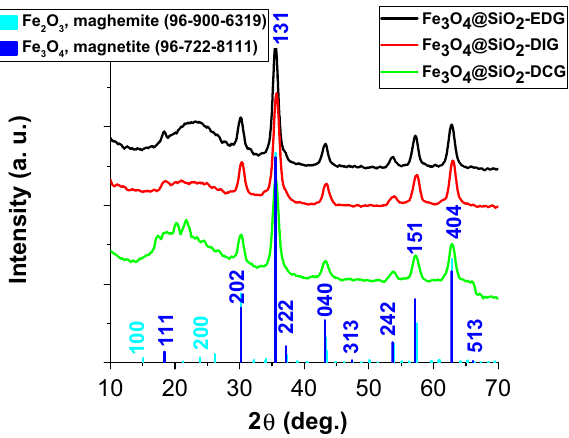
Figure 5. XRD analysis of the magnetic catalysts (Fe 3 O 4 @SiO 2 -DCG, Fe 3 O 4 @SiO 2 -DIG, and Fe 3 O 4 @SiO 2 - EDG).